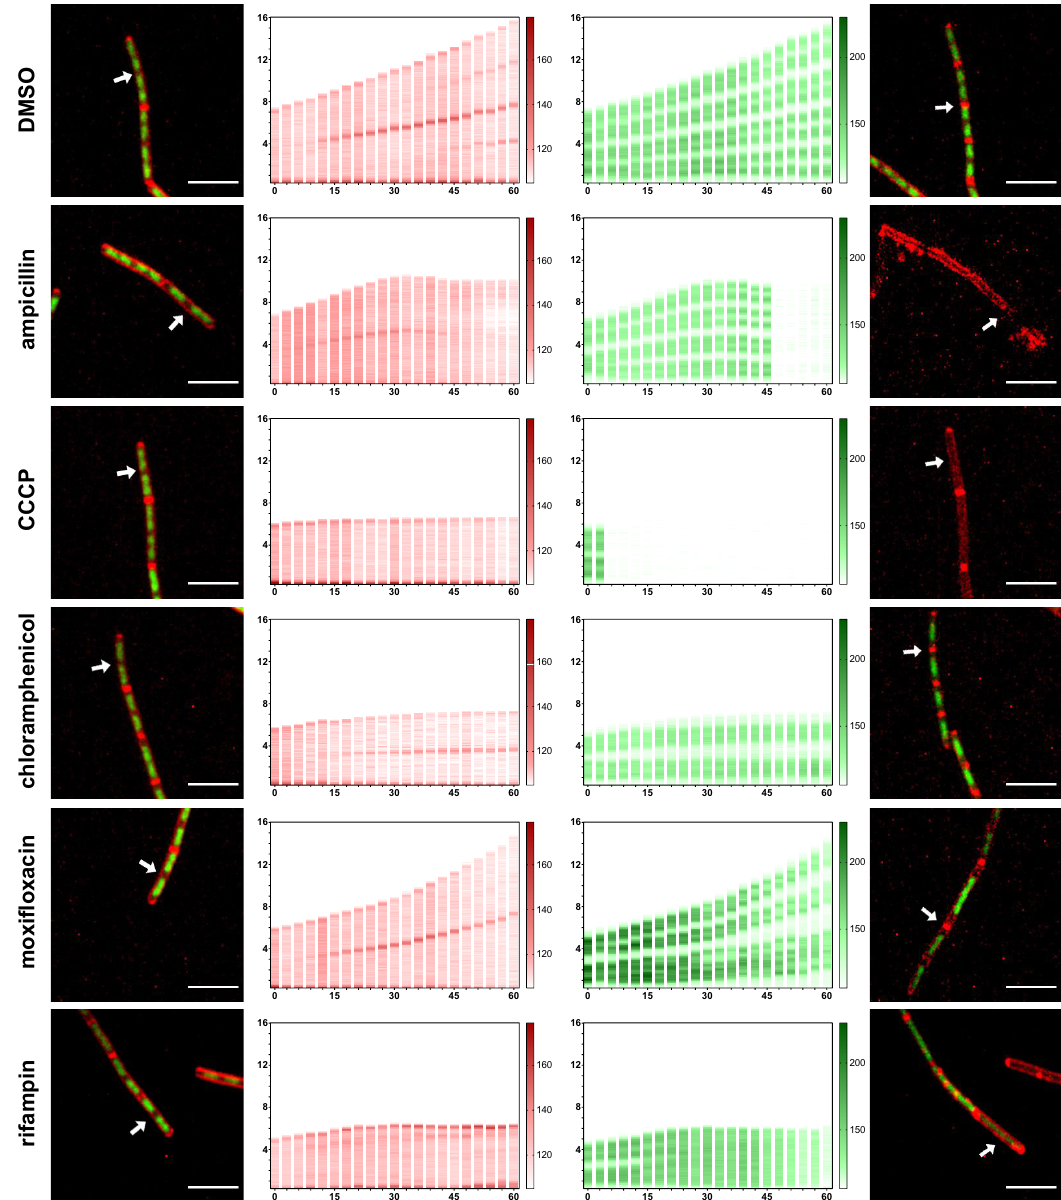
Figure 3. Distinct DBMI patterns of cells upon antimicrobial treatments. B. subtilis cells were treated with antimicrobials (2.5 × MIC) as indicated or 1% DMSO (control). The antimicrobials were: ampicillin for cell wall, CCCP for cell membrane, chloramphenicol for protein, moxifloxacin for DNA and rifampin for RNA. Cells were stained with FM4-64 (red, cell membrane) and SYTO-9 (green, nucleoid) and imaged by time lapse confocal fluorescence microscopy for 60 min with 3 min intervals. The first and last column show the actual micrographs of the first and the last image of the series (contrast was adjusted for individual graph to show details). The FM4-64 (second column) and SYTO-9 (third column) signals in a single cell (arrow in micrographs) were quantified over the length of the cell and plotted (y-axis, numbers in µm) over time (x-axis, numbers in min). Representative cells are shown. Scale bar is 5